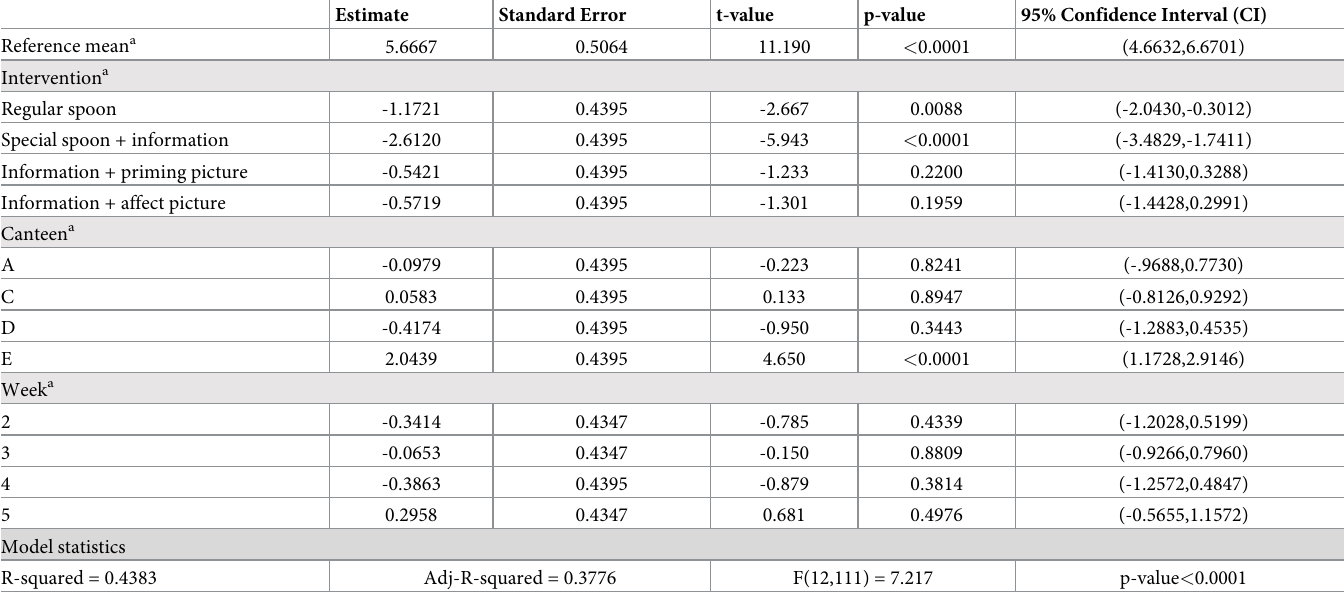
Table 4. Model results for the outcome measurement: Amount of fish sauce used (grams) per bowl to which fish sauce was added per day.